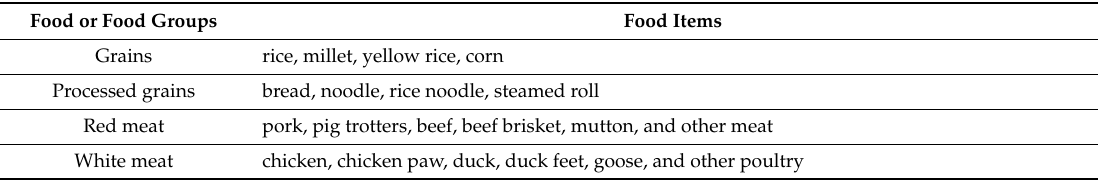
Table A1. Food groupings used in the dietary pattern